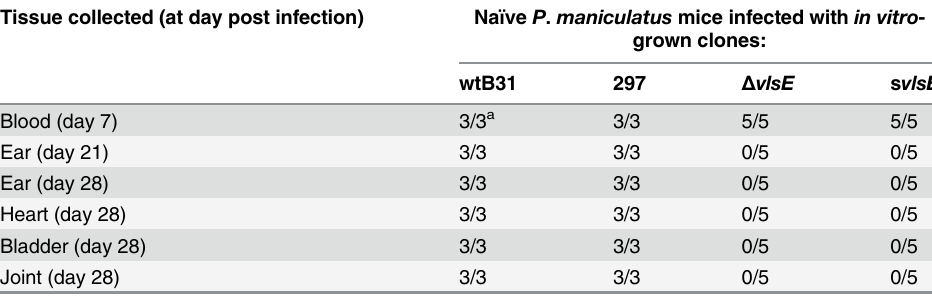
In order to examine if the vls mutant clones have the capacity to be acquired by I . scapularis ticks during feeding, naïve C3H/HeNHsd (C3H) mice were subcutaneously inoculated with ei- ther wild-type or vls mutant B . burgdorferi at 1.1x10 4 total spirochetes per animal. All mice be- came infected with each respective B . burgdorferi clone as determined by culture-positive Table 2. Infectivity of in vitro-grown B . burgdorferi clones in P . maniculatus mice. Tissue collected (at day post